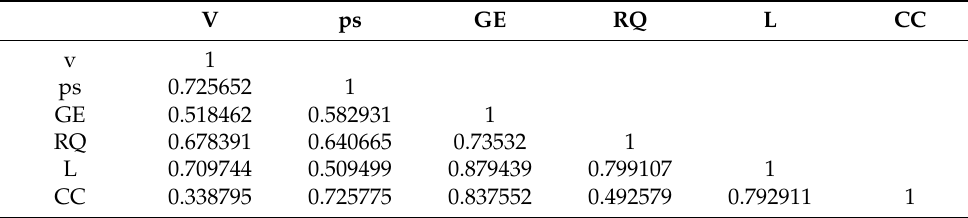
Table 3. Pair-wise correlation of institutional quality proxies (WGI).